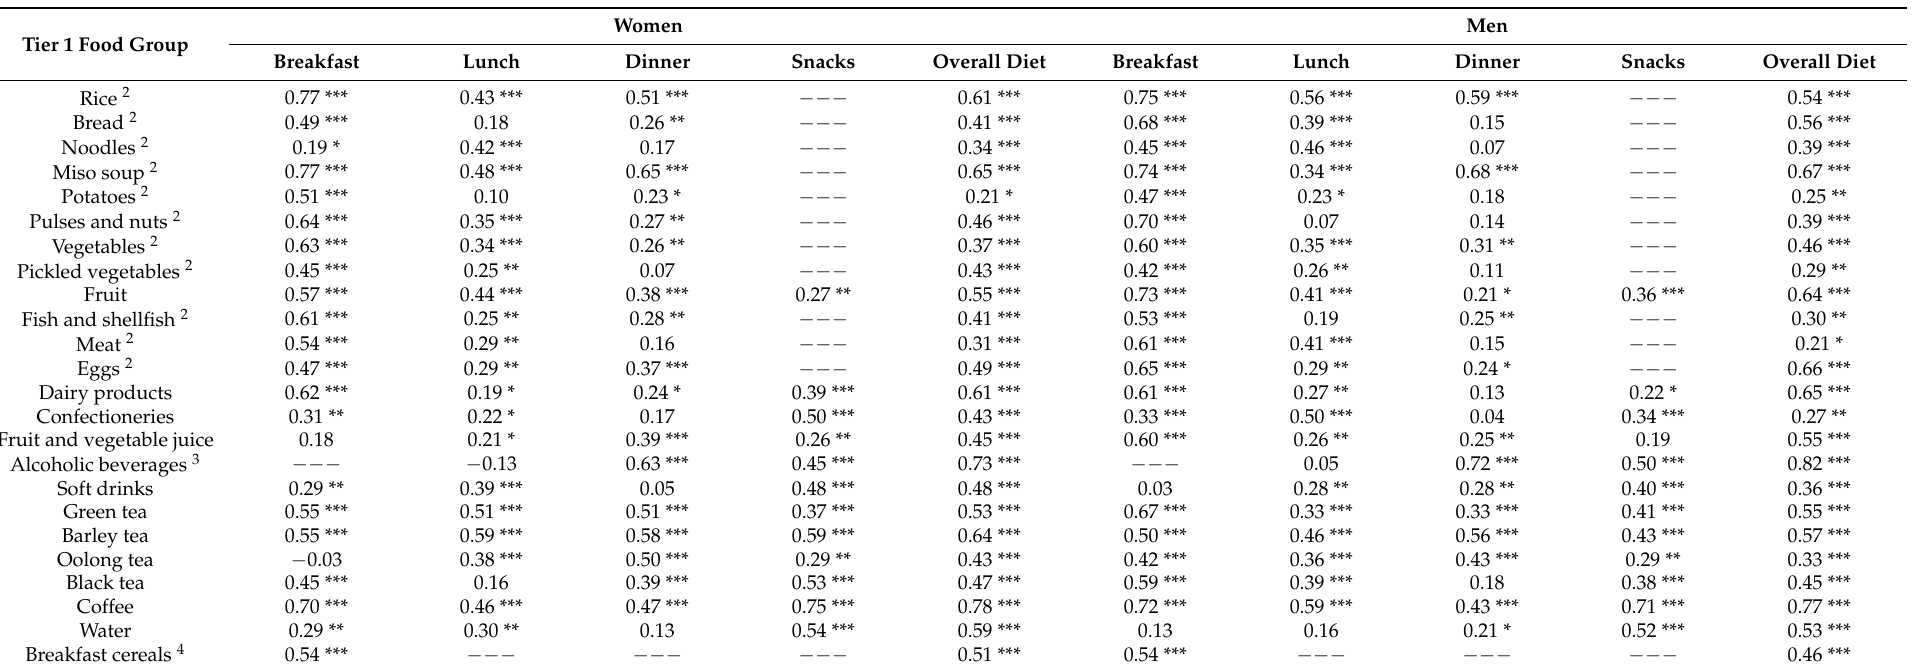
Table 4. Spearman’s correlation coefficients between estimates of daily intakes of Tier 1 food groups (in grams per day) derived from the 4-day weighed dietary record and those derived from the web version of the Meal-based Diet History Questionnaire (MDHQ) in 111 Japanese women and 111 Japanese men, according to meal type 1